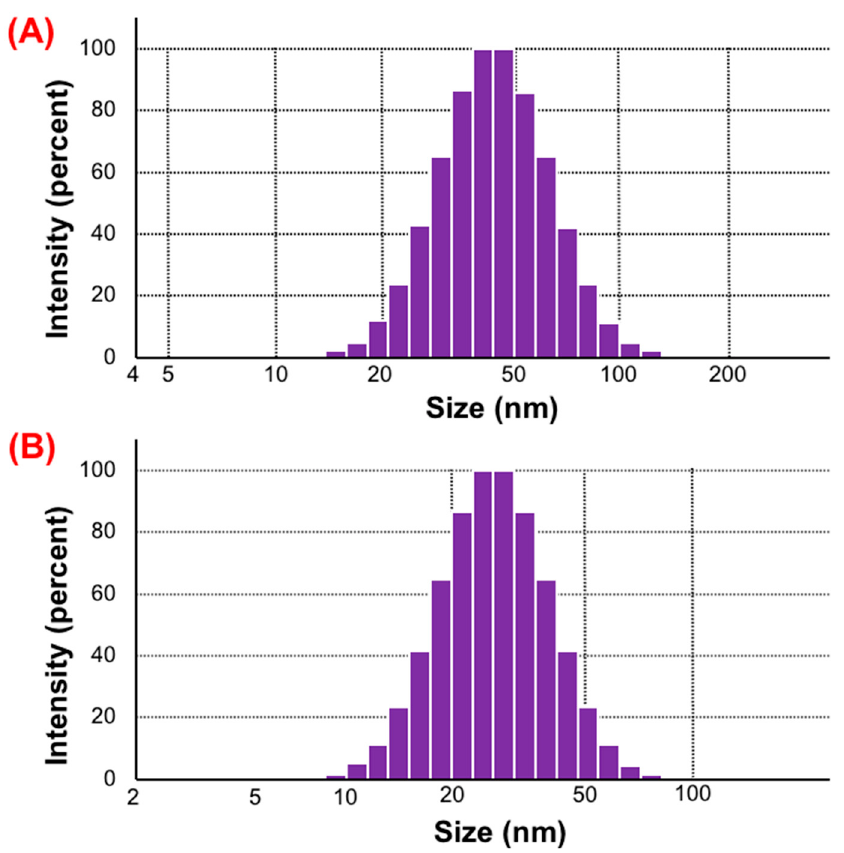
Figure 5. Characterization of GTP-PC-SNEDDS. ( A ): Particle Size distribution in dynamic light scat- tering (DLS) of SNEDDS at the dilution of 1:250 by pH 6.8 PBS. ( B ): Particle Size distribution DLS of SNEDDS at the dilution of 1:250 by pH 1.0 HCl. Table 10. Stability of particle size after self‑microemulsifying in 0.1 M HCl, pH 6.8 PBS, and distilled ◦ water at 37